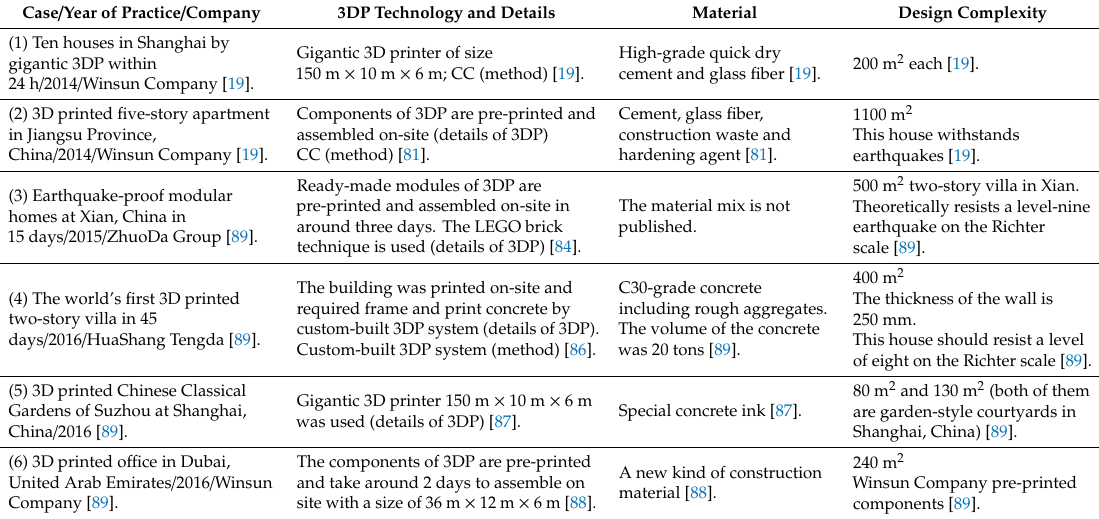
Table 8. Summary of selected 3DP